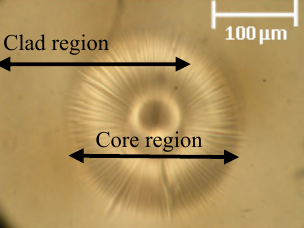
Figure 12. The microscopic picture of the core–clad interface of erbium-doped germanium–alumina– silica fiber preform.